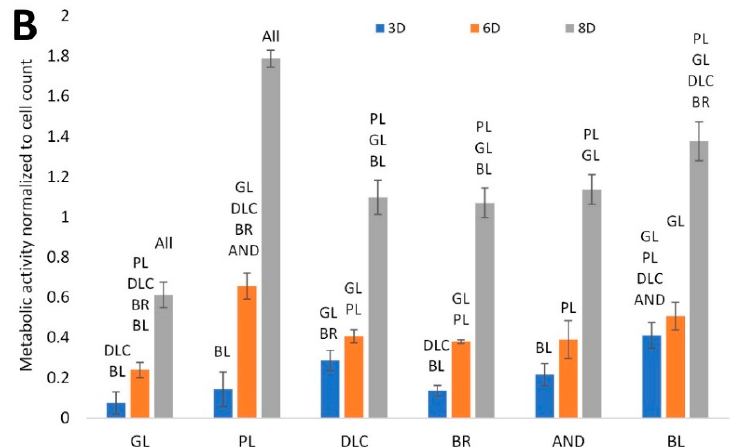
Figure 4. ( A ) Cell counts on the reference glass coverslips (GL) and on the Ti6Al4V samples modified by polishing (PL), by DLC-coating (DLC), by brushing (BR), by anodizing (AND), or by blasting (BL), estimated by the intensity of the fluorescence of the cell nuclei on microscopic images taken on days 3, 6, and 8 of cell cultivation; the values are normalized to the glass control on day 3. ( B ) Metabolic activity of cells on the control glass and on the treated titanium surfaces; the values are normalized to the cell counts. Average ± SD from 15 (cell counts) / 4 (metabolic activity) samples. ANOVA, statistical significance ( p ≤ 0.05) in comparison with other experimental groups is marked by abbreviations of these groups above the columns.